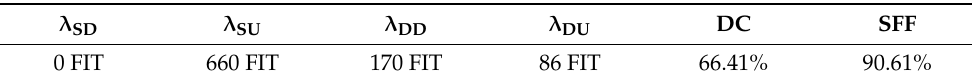
Table 4. Failure rates, DC (diagnostic coverage), and SFF (safe failure fraction) for the logic solver under analysis.